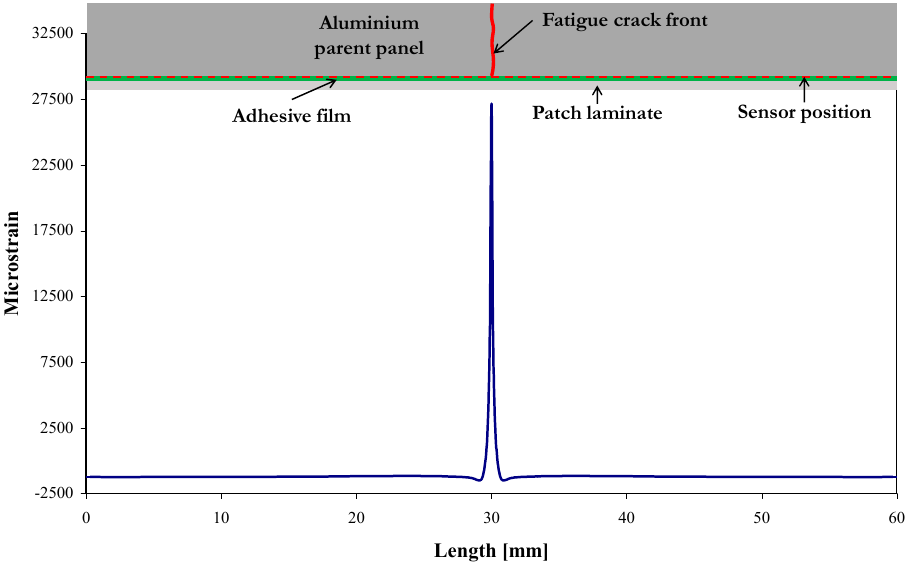
Figure 13. Predicted strain profile along the position of the 60 mm sensor in the damaged model (12.5 mm crack) when loaded at 6 kN.